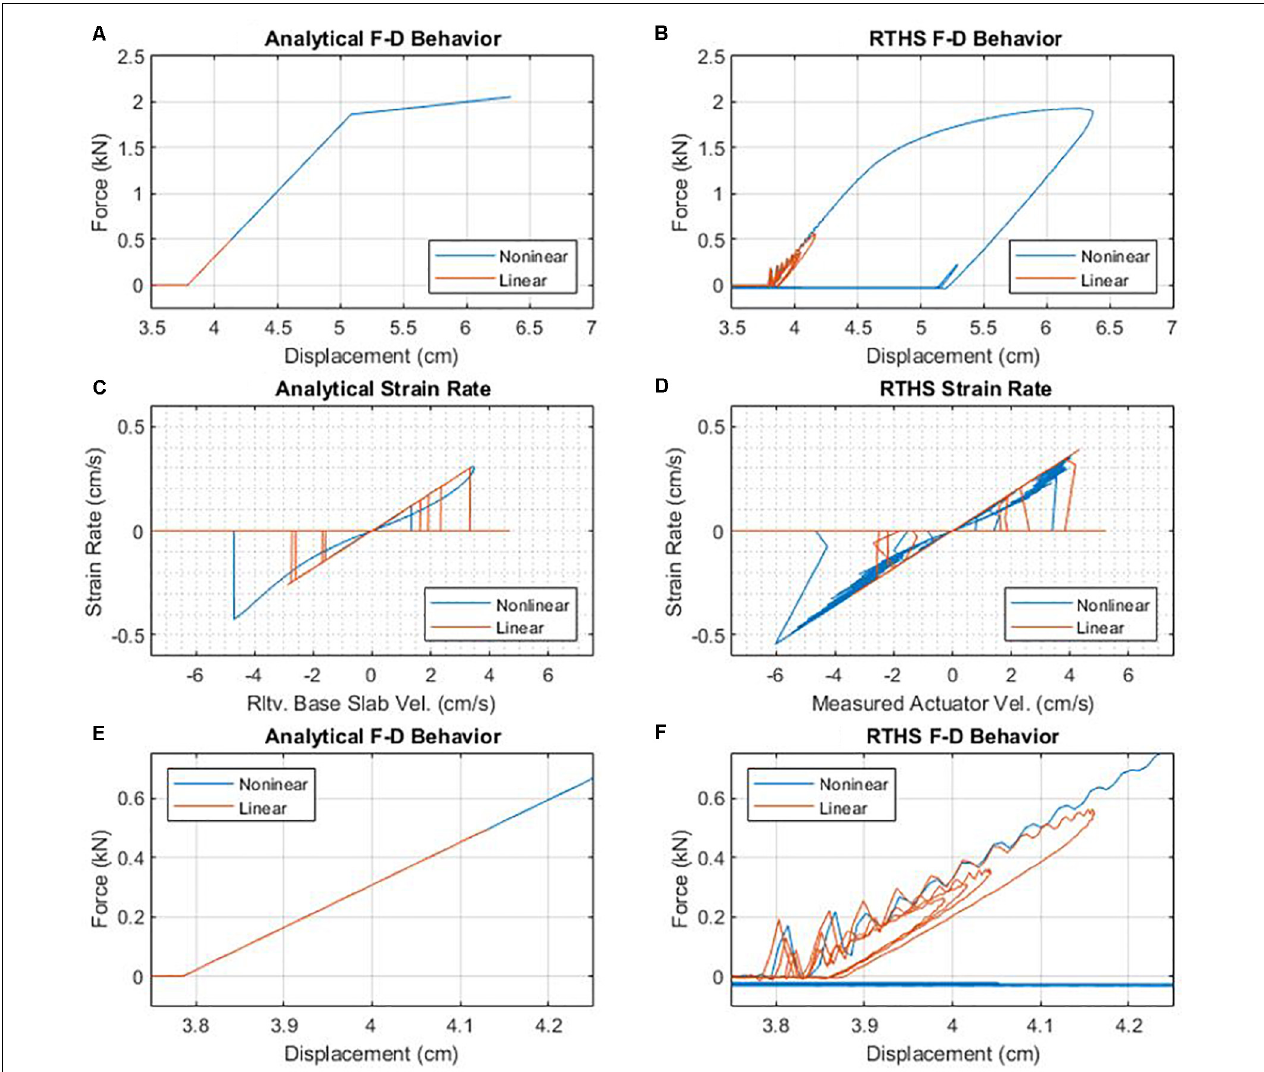
FIGURE 12 | The force displacement behavior as observed during impact by (A) numerical simulation and (B) RTHS testing, the deformation strain-rate dependency obtained by (C) numerical simulation and (D) RTHS testing, and a zoomed-in view of the force-displacement behavior obtained by (E) numerical simulations and (F) RTHS